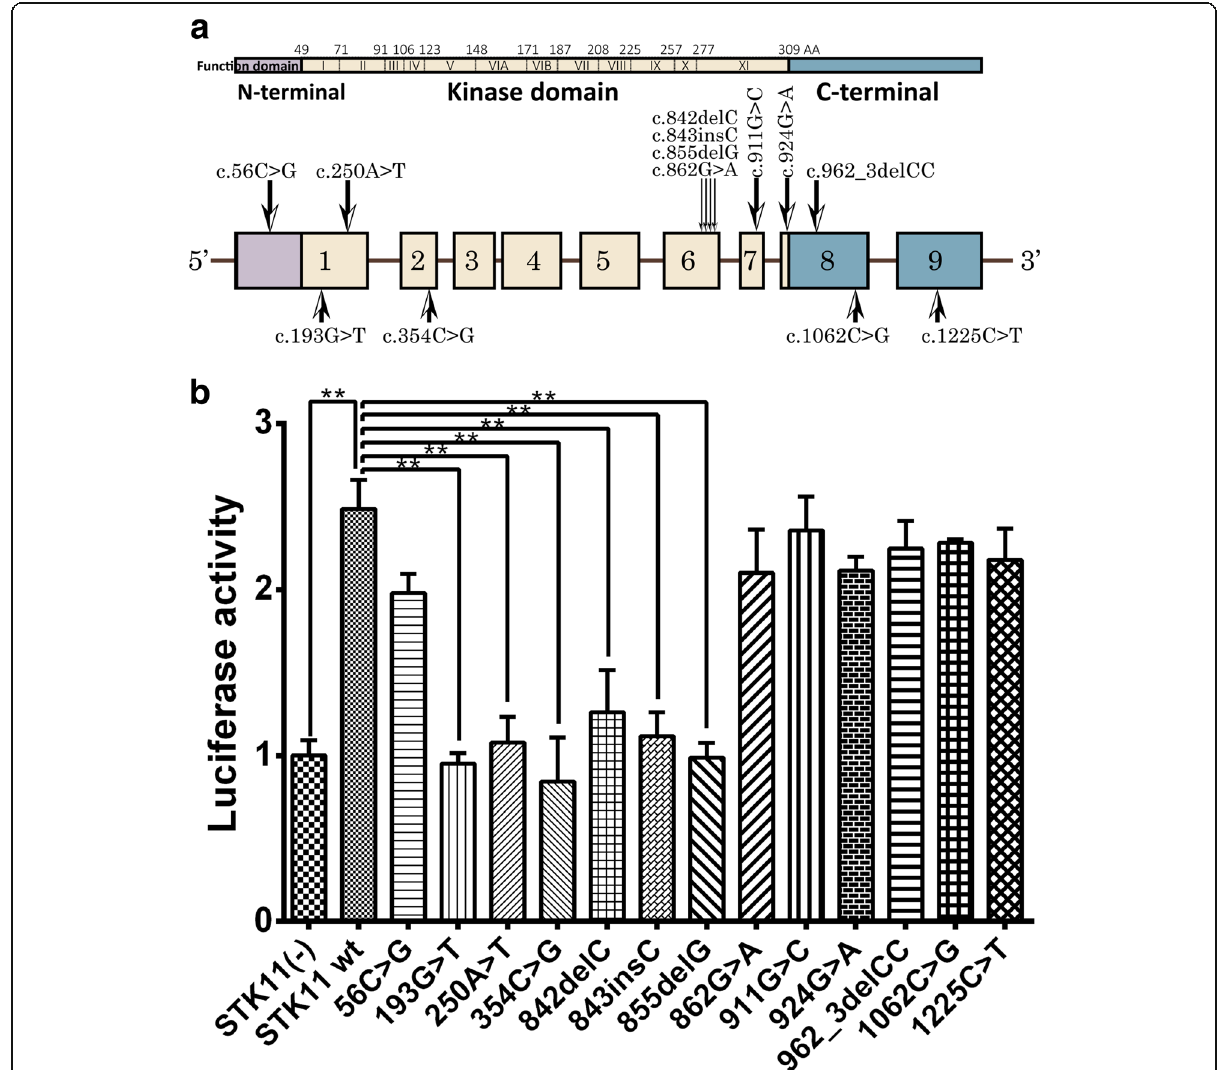
Fig. 2 Distribution of all the STK11 mutations detected ( a ) and P53 pathway activity tested by dual-luciferase reporter gene technique in HEK293T cells transfected with these mutants (3 replicates) ( b ). Double-asterisks present significant ( p <